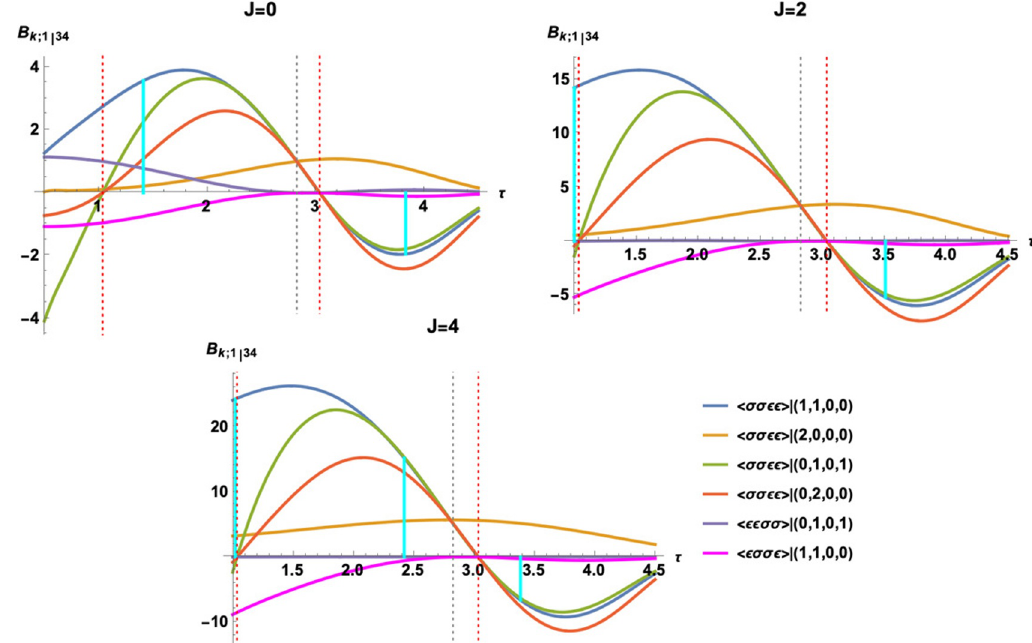
for fixed spin J as a function of twist τ for channels where even Z Figure 11 . B k ;1 | 34 exchanged. We have included all three correlators h σσ(cid:15)(cid:15) i , h (cid:15)(cid:15)σσ i and h (cid:15)σσ(cid:15) i to highlight differences between subtraction schemes and operator